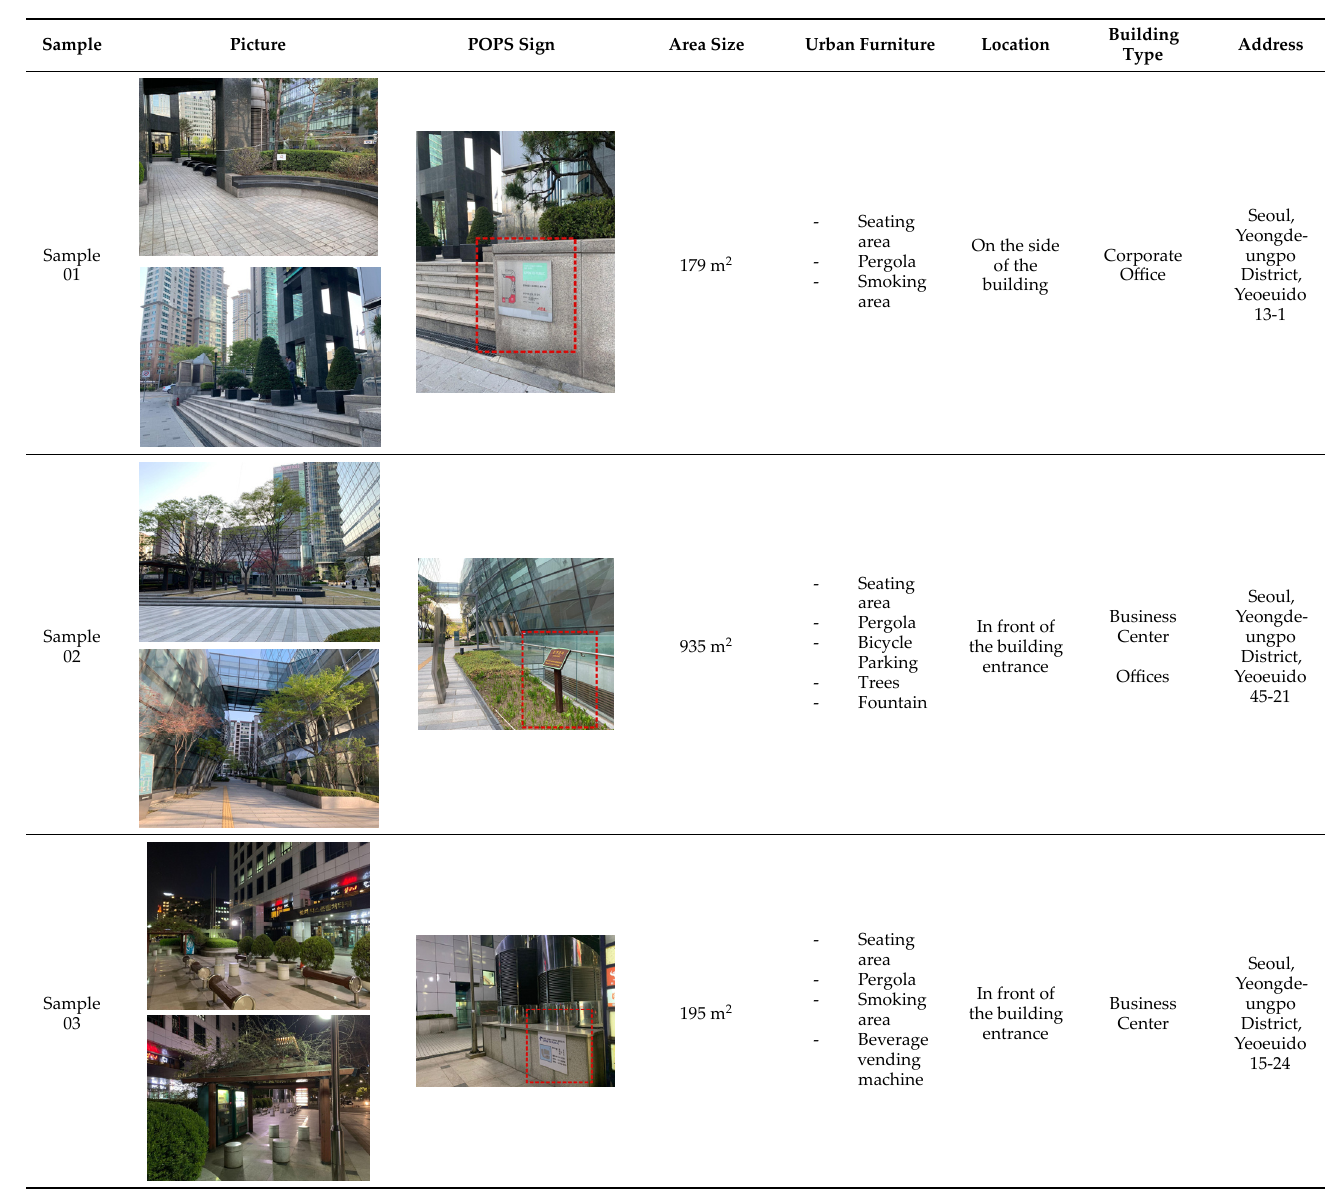
Table 1. Four samples of this study. Figure 2. The location of Yeouido Business District within Seoul city and the distribution of POPS on site (source: author analysis with a base from blcm.go.kr., accessed on 8 June 2022).